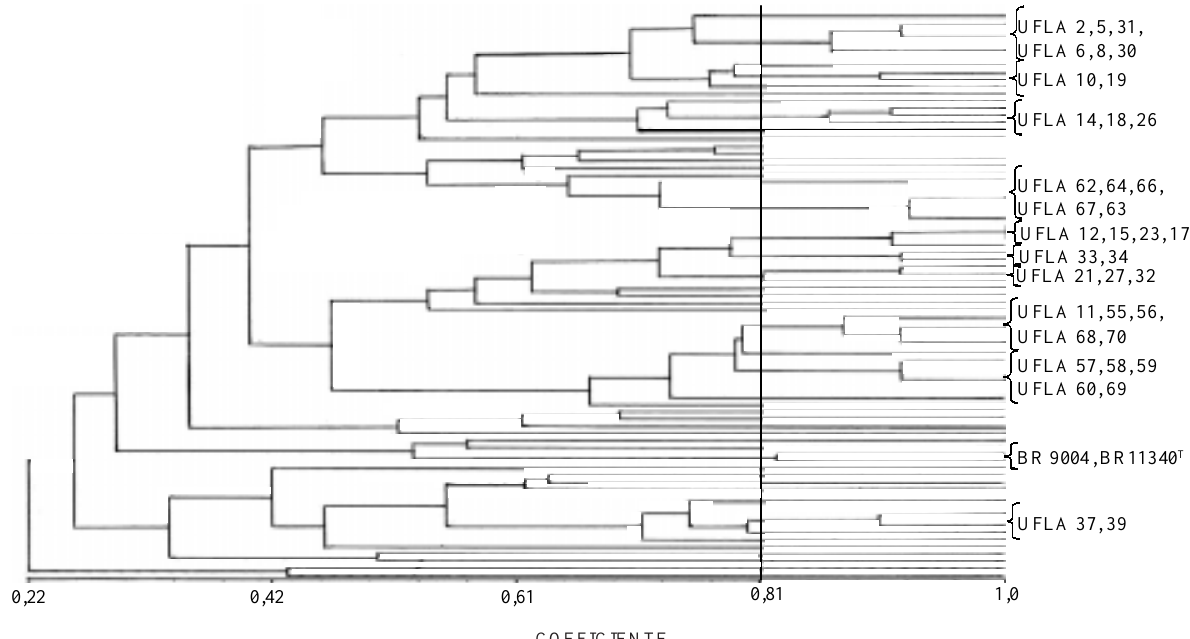
Figura 1. Dendrograma de similaridade construído de acordo com as características culturais de bactérias diazotróficas isoladas em amostras de solos de áreas reabilitadas de mineração e as estirpes tipo BR11001 T , BR11080 T , BR11040 T , BR9004, BR11340 T , BR11175 T , KBC1 T